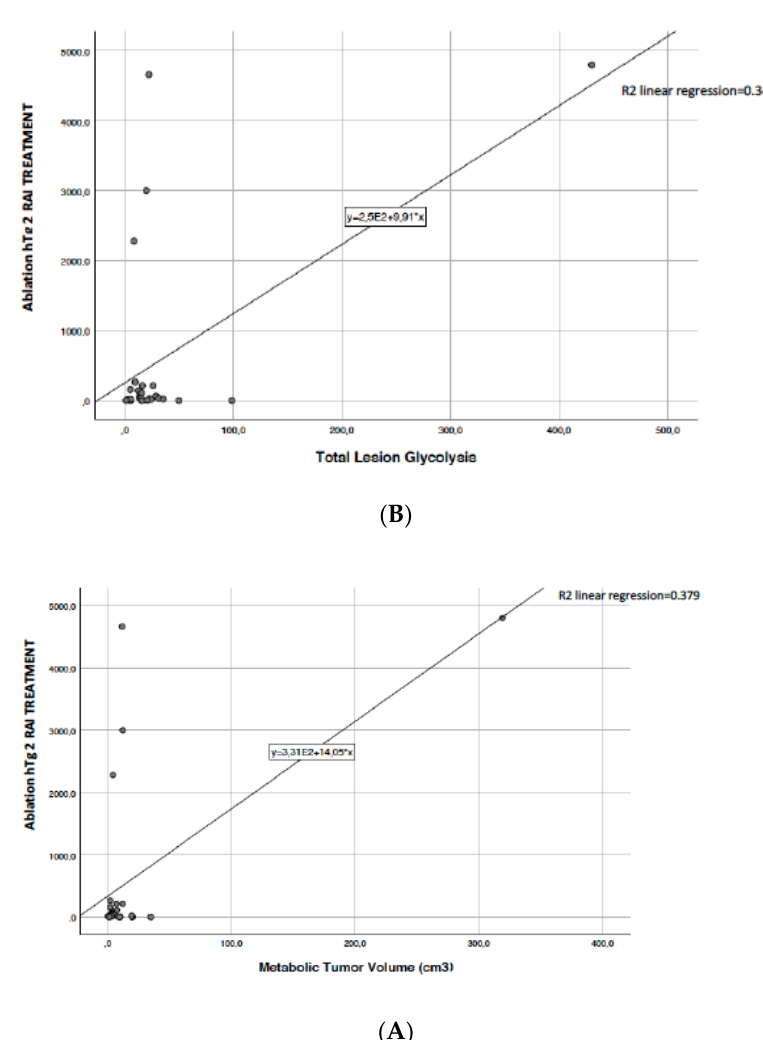
Figure 2. Correlation between MTV (Panel A ), TLG (Panel B ), and stimulated thyroglobulin.